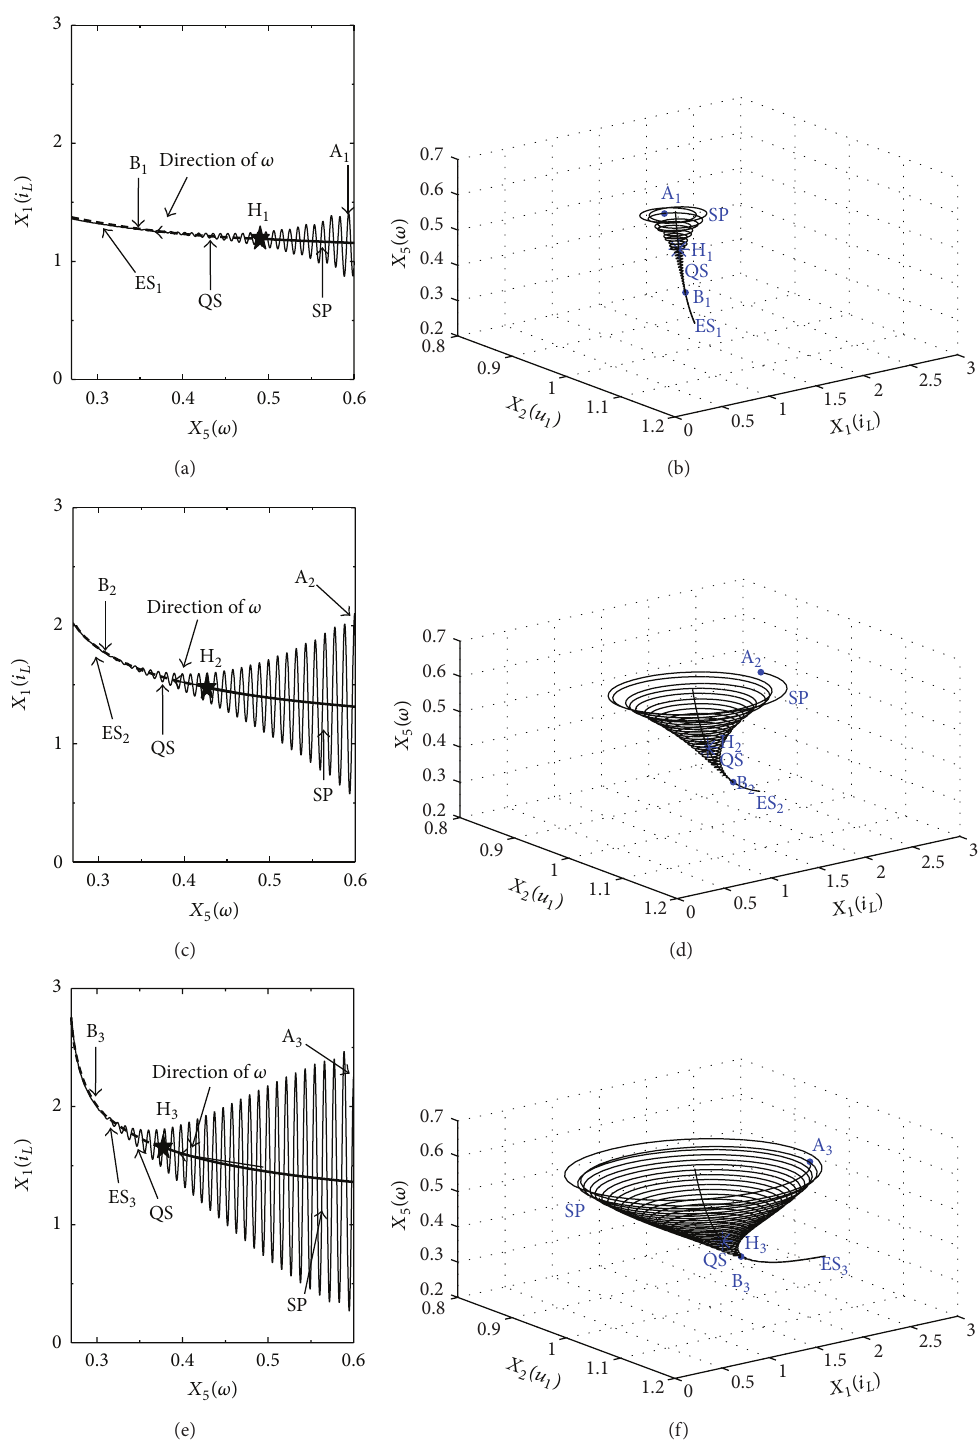
Figure 10: Stroboscopic phase trajectory of the full-system as well as the transient fixed points curves under different 𝑉 dimensions at (a)-(b) 𝑉